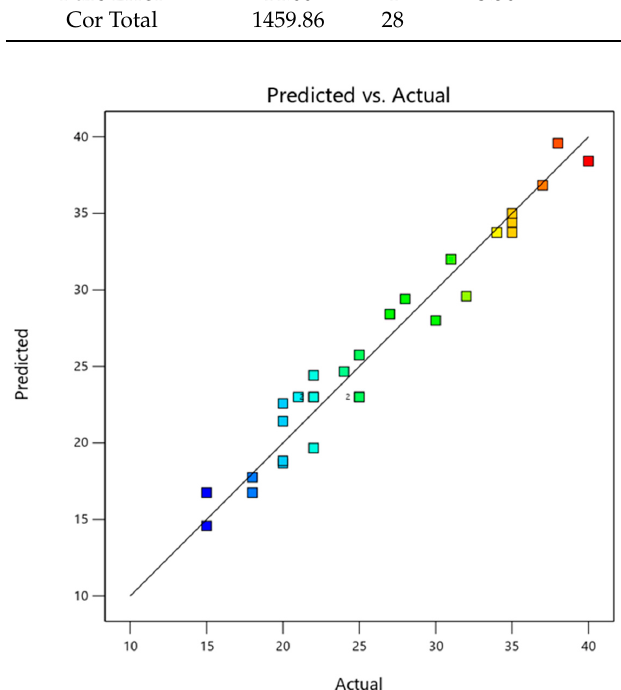
Figure 5. Predicted response vs. actual response for surface area.